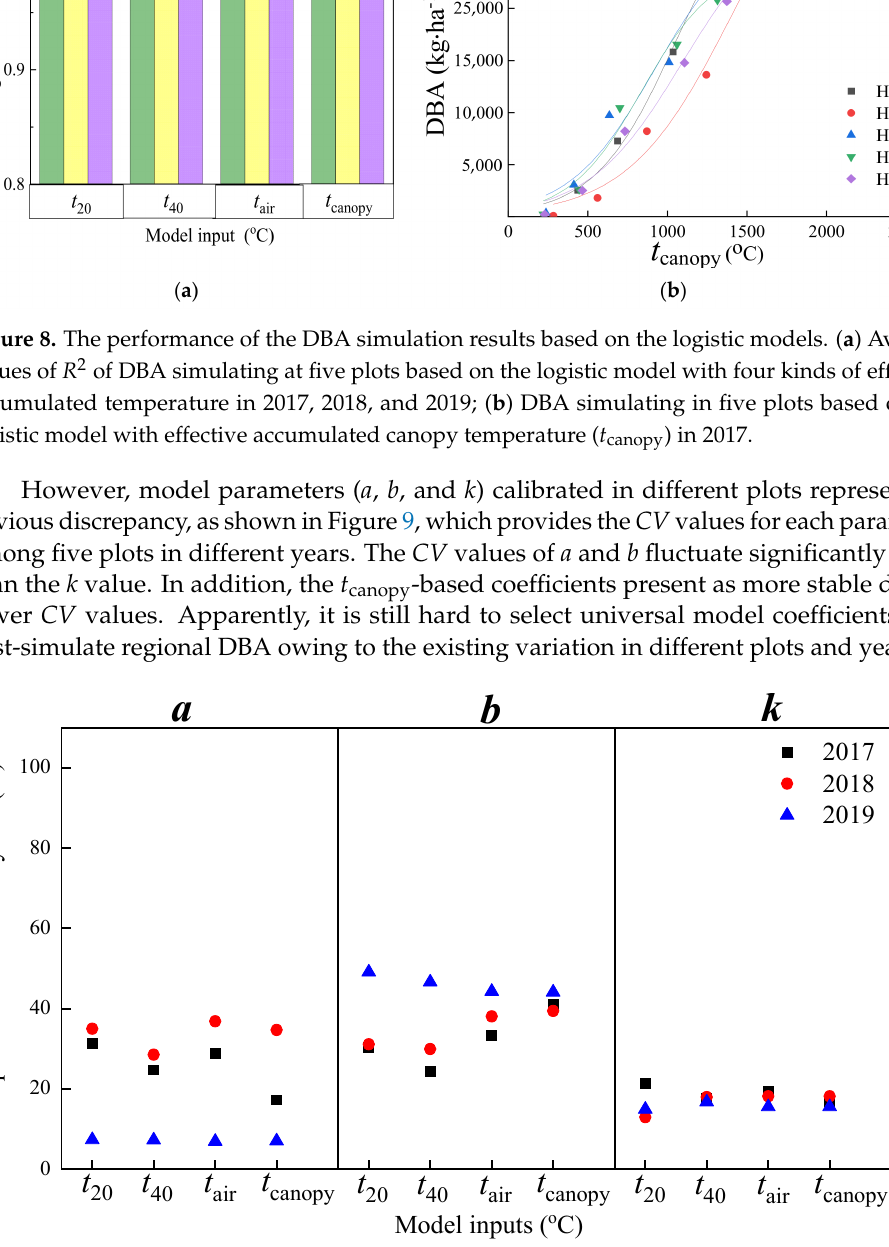
Figure 9. The CV values for each logistic model parameter ( a , b , k ) with four inputs ( t 20 , t 40 , t air , t canopy ) among five plots in 2017–2019.